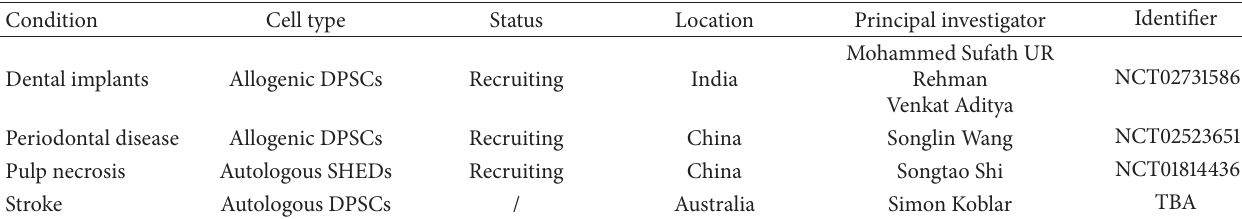
Table 3: Clinical application of